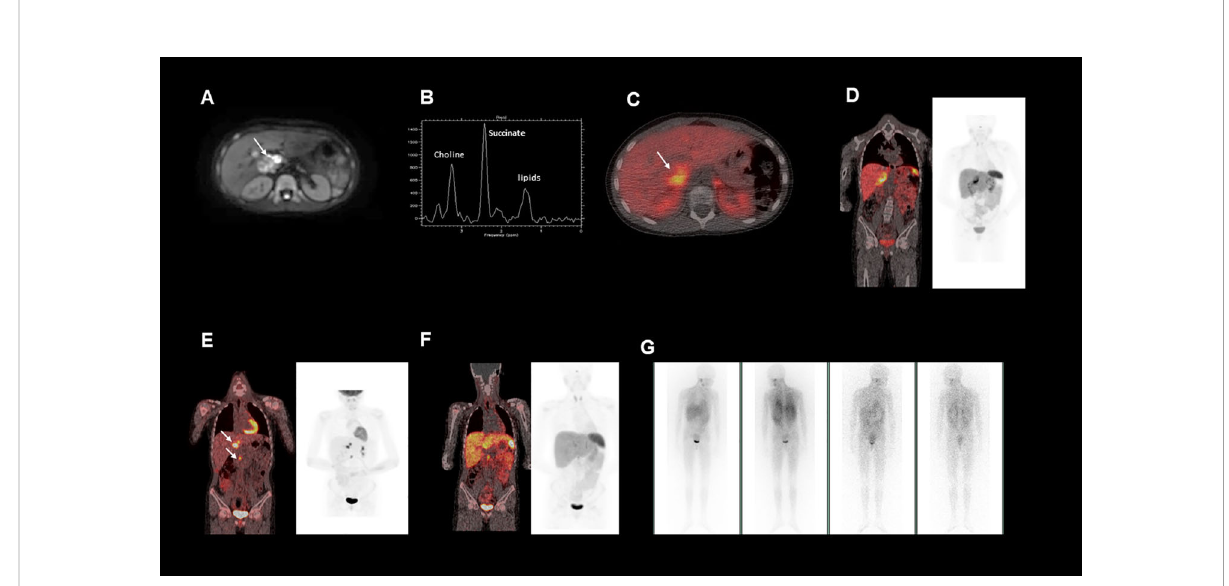
FIGURE 1 (A) , This is an axial diffusion-weighted MRI image showing a right sided heterogeneous suprarenal mass. (B) , MRI spectroscopy acquired from a voxel placed within the right suprarenal mass demonstrated a high succinate concentration. (C , D) , show fused axial and coronal images from